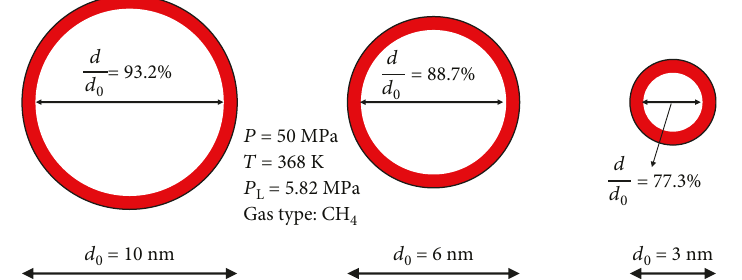
Figure 2: The e ff ect of the adsorbed layer on the e ff ective sectional fl ow area of pores of di ff erent diameters. Activated transition state